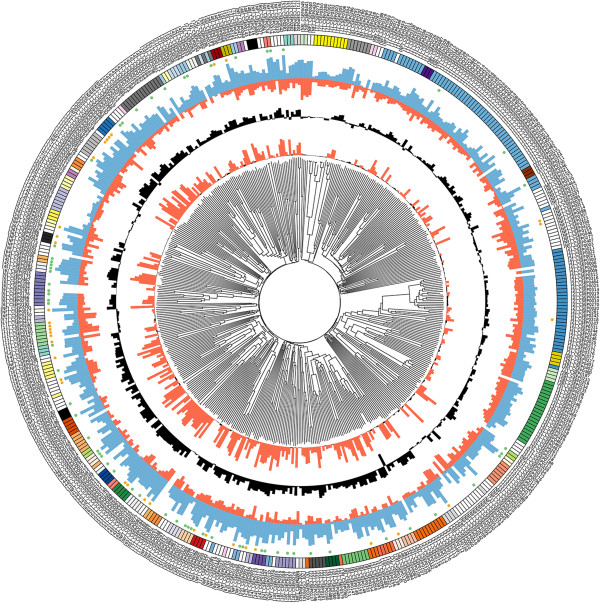
CIRCOS plot of the CSEP superfamily with expression and proteome data. From the perimeter to the centre: The outer ring identifies the CSEPs. The rectangles in the circle immediately below the identifiers are colour-coded: CSEPs of the same families have the same colour. The small circles below the family identifiers indicate the proteins identified by mass spectrometry in infected epidermis only (green) or in both infected epidermis and epiphytic hyphae (yellow). The first and second data histogram circles shows the expression values of the haustorial samples (blue) and of the epiphytic samples (red) of each CSEP gene on a log2 scale. The third data histogram (black) represents the ratio of the expression values in the two stages plotted on a log2 scale. The fourth data circle indicate the statistical significance of the ratios (red, significant/black non-significant). At the centre is a dendrogram based on the neighbour-joining dendrogram of all CSEP paralogs.